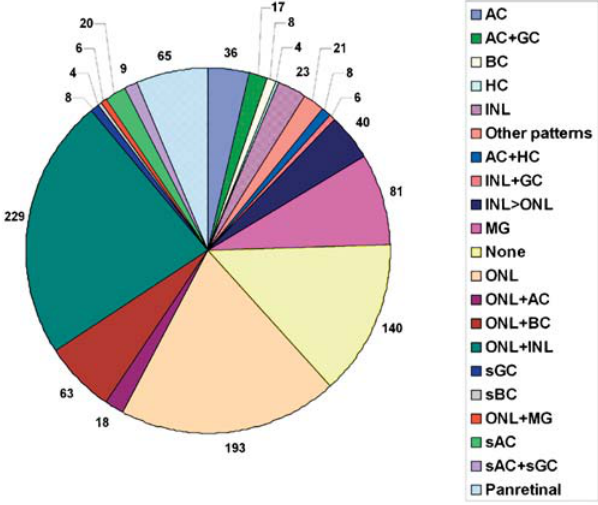
Figure 7. Catalog of Gene Expression in Adult Retina The most commonly observed patterns of gene expression in the adult retina are indicated. Data are taken from Table S5 and cover all genes examined in the adult retina. Genes are placed in a category corresponding to a single cell type if expression is substantially greater in that cell type than in any of the other cell types examined. Genes are placed in categories corresponding to multiple cell types if expression is approximately equal in more than one cell type. The number of genes expressed in photoreceptors and Mu¨ller glia differs somewhat from those used in the analysis shown in Figure 5A, since the expression of a large number of photoreceptor-enriched genes was not examined prenatally, and a number of Mu¨ller-enriched genes were detectable in Mu¨ller glia through the end of the second postnatal week, but not in adult retina. AC, amacrine cells; BC, bipolar cells; GC,ganglion cells; HC, horizontal cells; MG, Mu¨ller glia; sAC, subset of amacrine cells; sBC, subset of bipolar cells; sGC, subset of ganglion